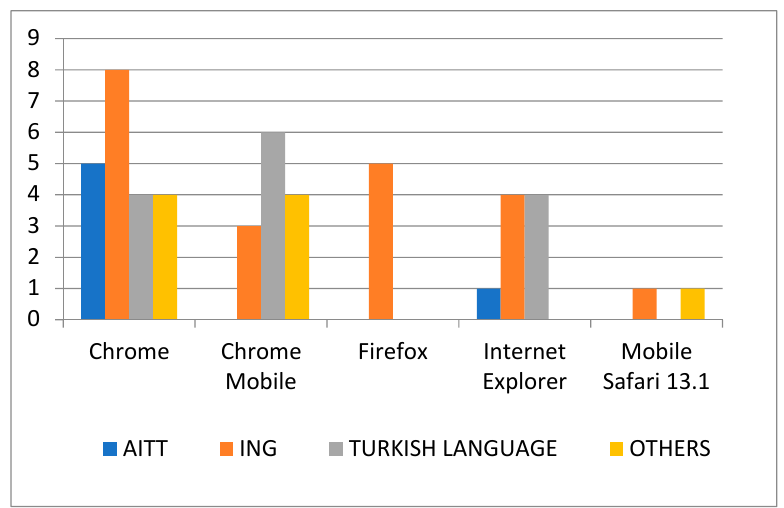
Figure 1. Distribution of support requests by related course and internet browser used